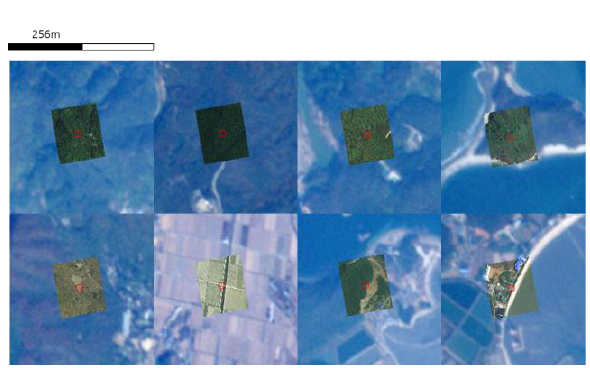
Figure 6. GCP Chips that matched as outlier.